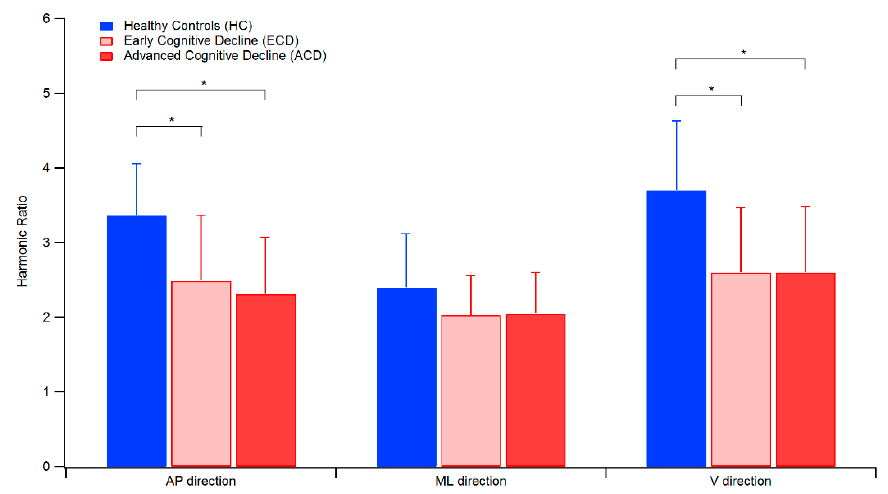
Figure 1. Trend of HR values for the three groups of tested elderly. The symbol * denotes a statistically significant difference after Bonferroni correction (p < 0.016)